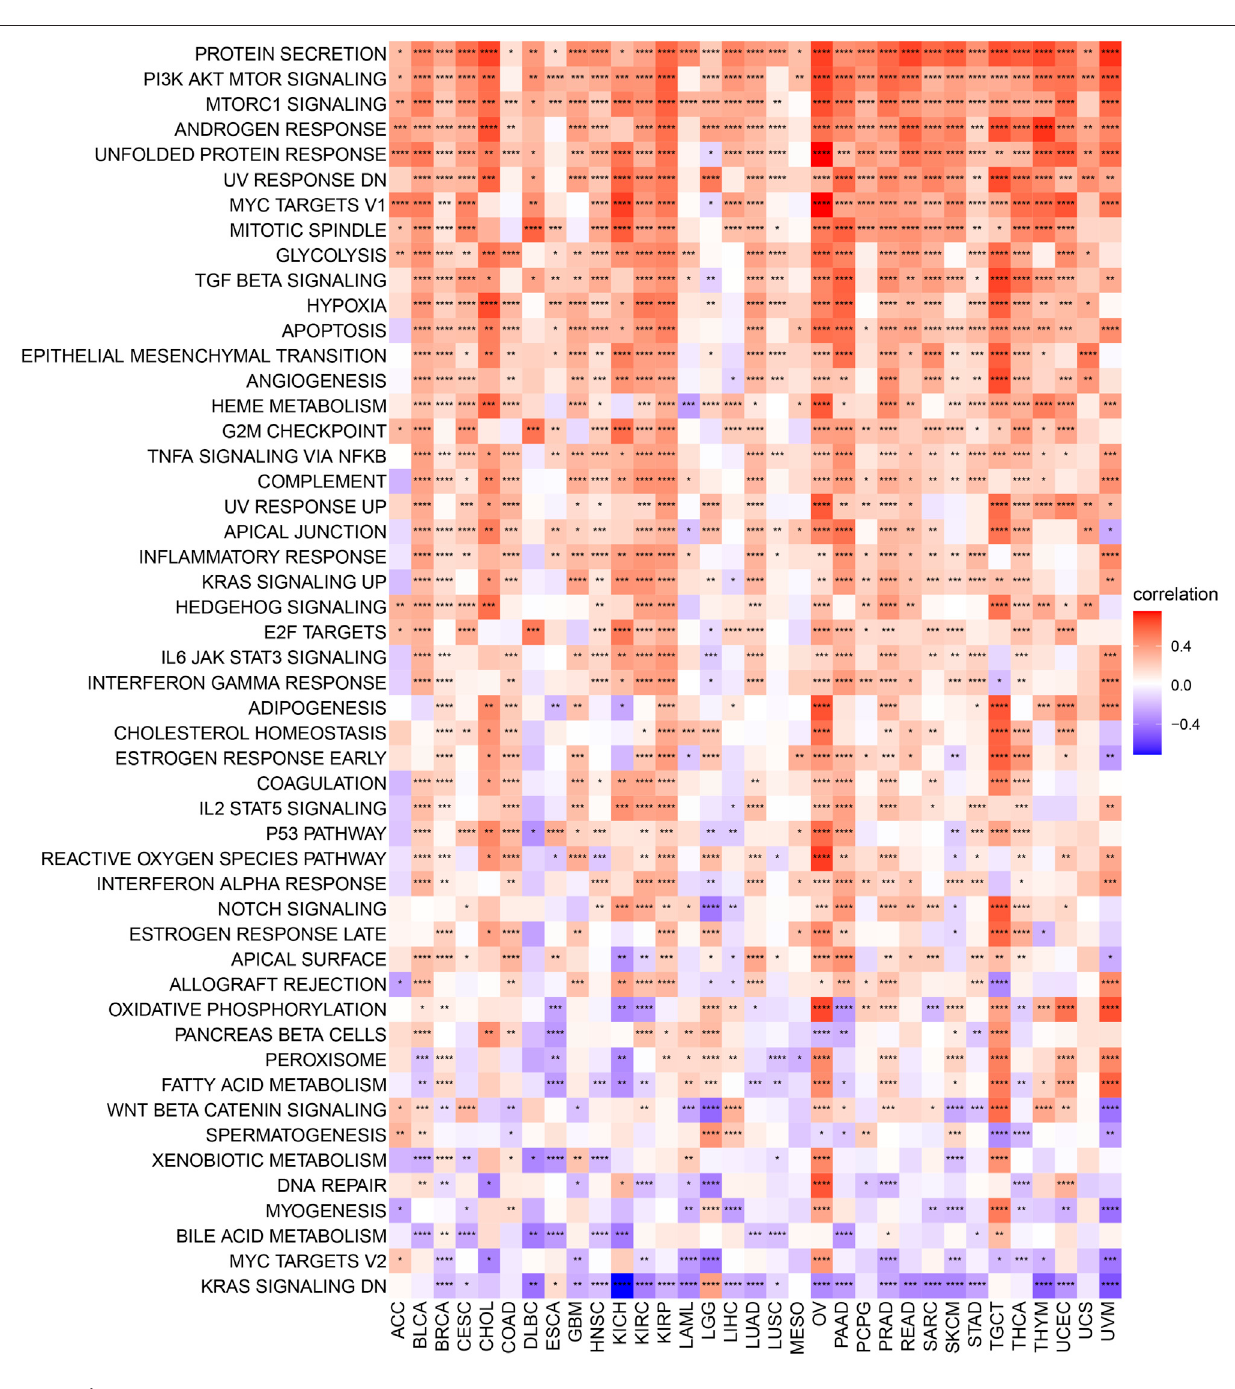
Frontiers in Cell and Developmental Biology |